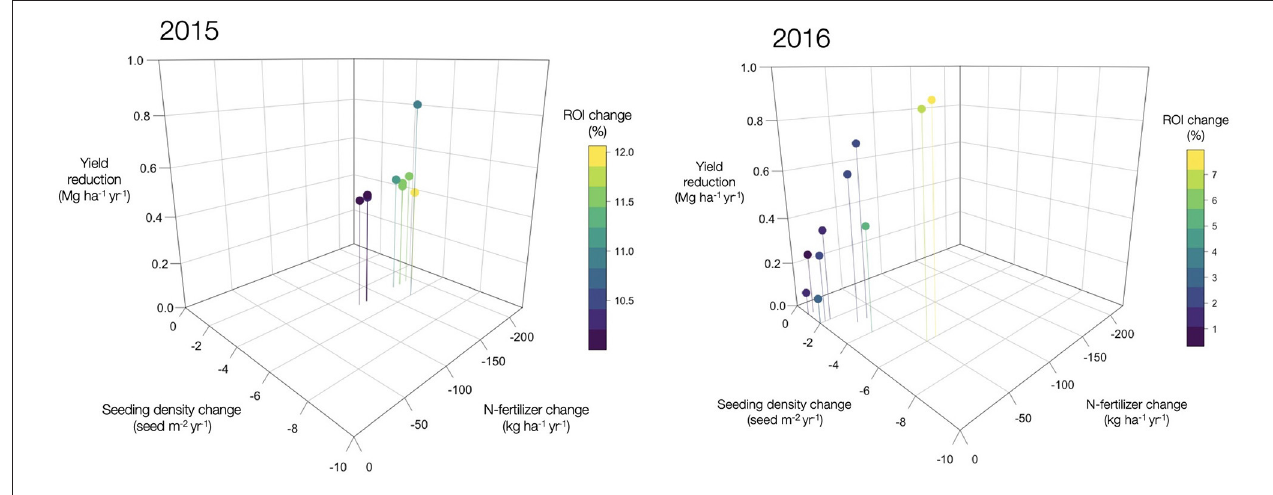
FIGURE 10 | Yield and ROI changes associated with a shift from agronomic optimum inputs to economic optimum inputs. Data points represent changes corresponding with each subfield soil types during 2015 and 2016 ( Table S7